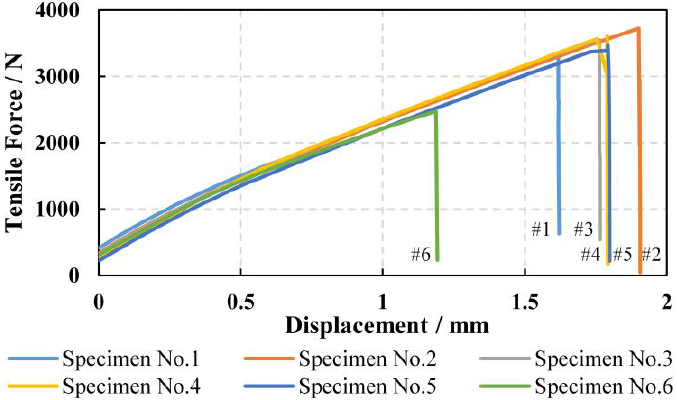
Figure 5. Displacement vs. transverse tensile force curves for six UD CFRP specimens. Table 3. Transverse tensile strengths of the six UD composite